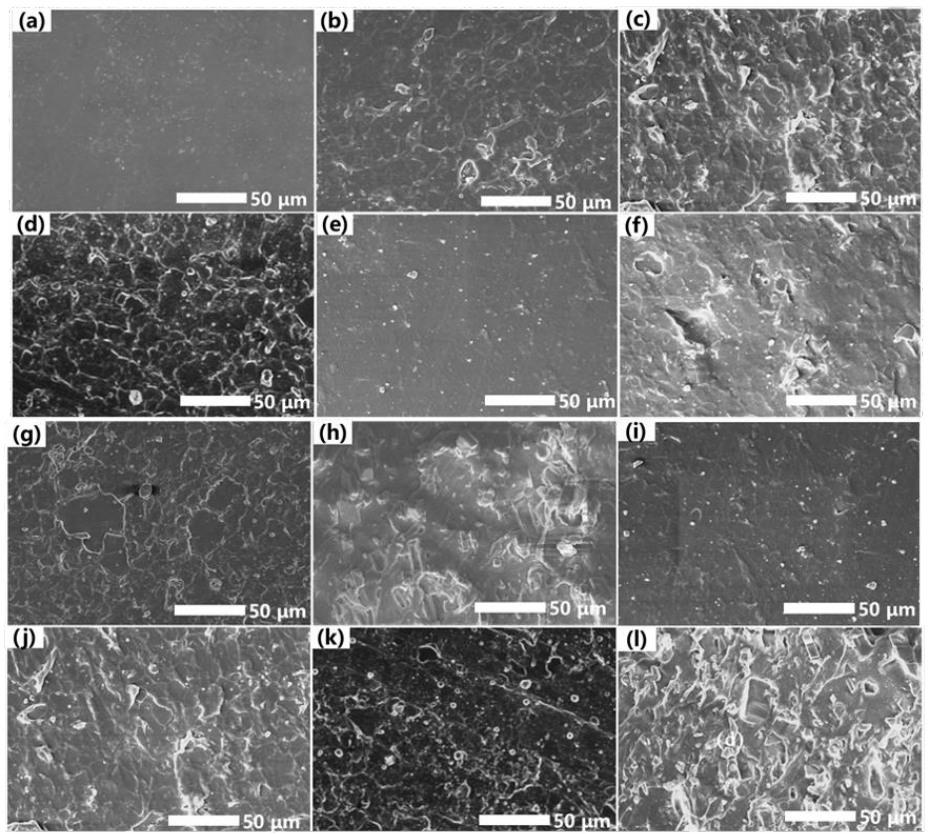
Figure 2. SEM images of ATH-0 SiR after NO 2 aging for 0 h ( a ), 12 h ( b ), 24 h ( c ), and 36 h ( d ); SEM images of ATH-90 SiR after NO 2 aging for 0 h ( e ), 12 h ( f ), 24 h ( g ), and 36 h ( h ); SEM images of ATH-180 SiR after NO 2 aging for 0 h ( i ), 12 h ( j ), 24 h ( k ), and 36 h ( l ).